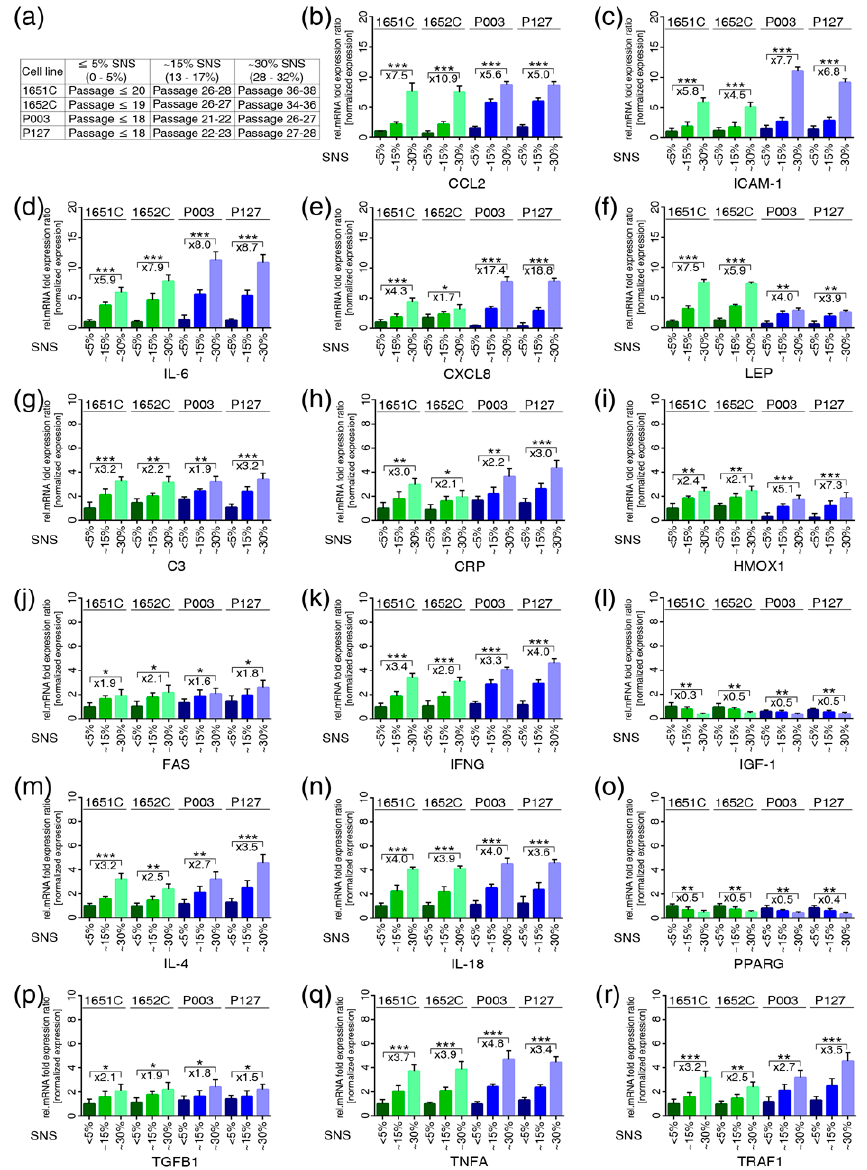
Figure 2. Quantitative real-time PCR analysis of the 17 genes identified by text mining in normal and HGPS cells during replicative senescence. ( a ) Table showing the cell strains and the passages corresponding percentage of senescence (SNS). ( b – r ) mRNA levels of the indicated genes were determined in controls (GMO1651c, and GMO1652c) and HGPS (HGADFN003 and HGADFN127) cell strains at the indicated percentage of senescence (SNS). Relative expression was normalized to the expression of GAPDH. Graphs show the mean ± SD (* p < 0.05, ** p < 0.01, *** p < 0.001, n > 3). The mean fold changes between 5% and 30% SNS for control and HGPS are